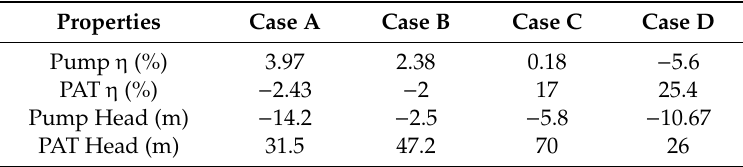
Table 10. Summarization of the optimized case